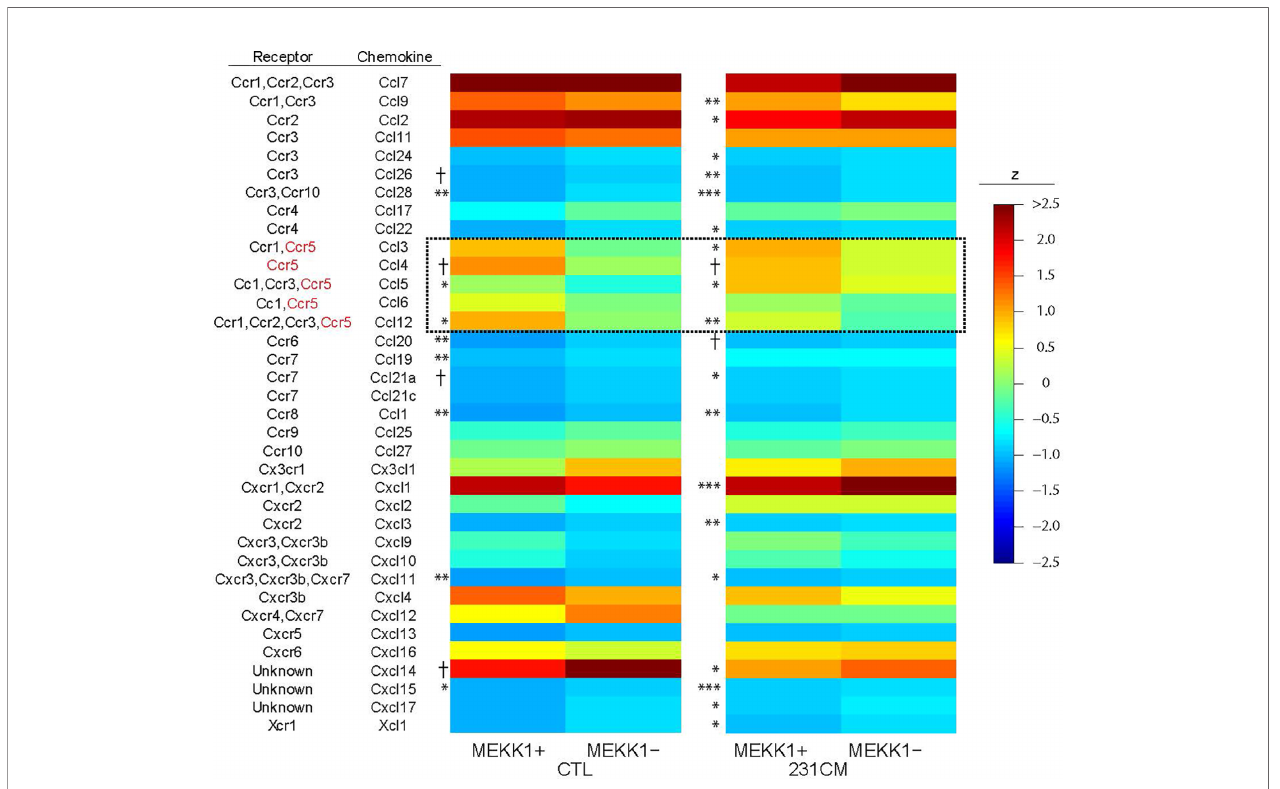
FIGURE 2 | CCL5 expression in primary mammary fi broblasts is enhanced by MEKK1. Heat map of z-score normalized microarray expression data for 36 chemokines in primary mammary fi broblasts cultured from six mice (3× MEKK1 +/+ and 3× MEKK1 − / − ) either unstimulated (CTL) or induced with cultured medium from MDA-MB-231 cells (231CM). Columns show mean expression by group (N=4 culture replicates per condition), with asterisks indicating signi fi cance by z-tests with Benjamini-Hochberg false discovery rate adjustment for multiple testing. *FDR < 0.05, **FDR <0.01, ***FDR < 0.001, † unadjusted p <